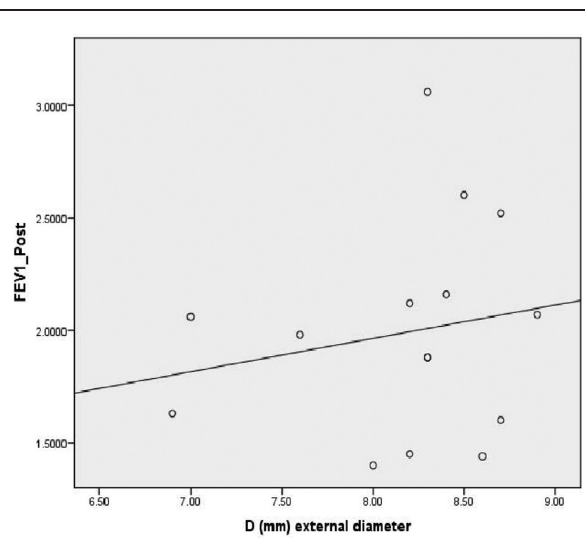
Correlation of a forced expiratory volume in 1s after bronchodilator therapy with airway external diameter assessed in HRCT among patients with asthma – chronic obstructive pulmonary disease overlap.